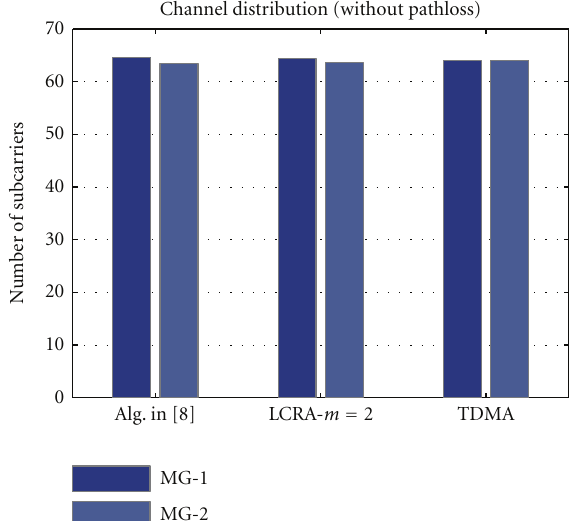
Figure 15: Channel distribution—no pathloss di ff erence between MGs.